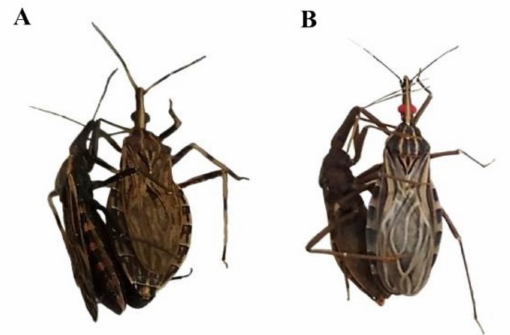
× R. brethesi ( A ) and R. prolixus ♀ ♂